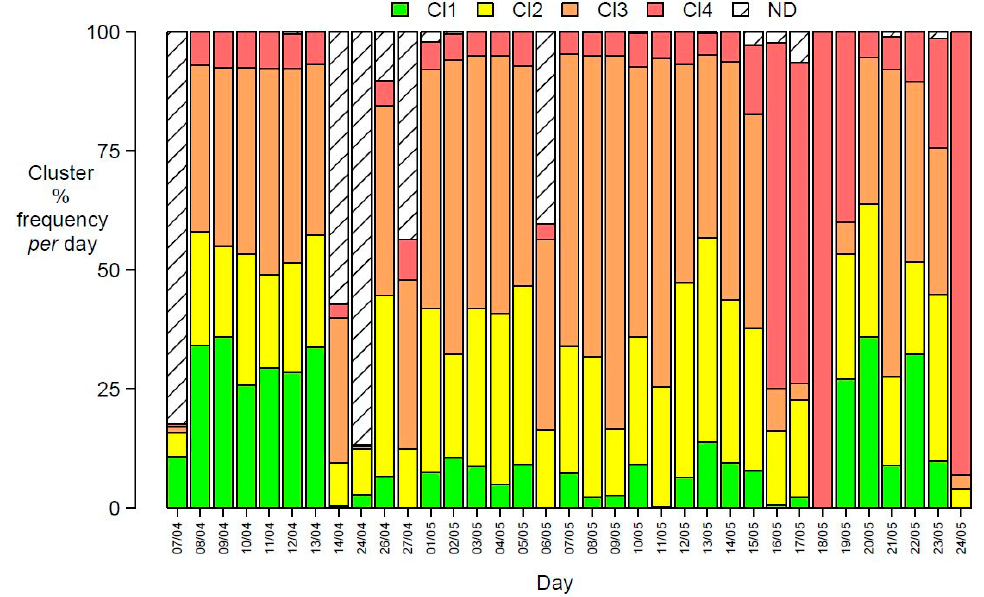
Figure 9. Cluster percentage frequency for each day (ND = data not recorded for power failure).